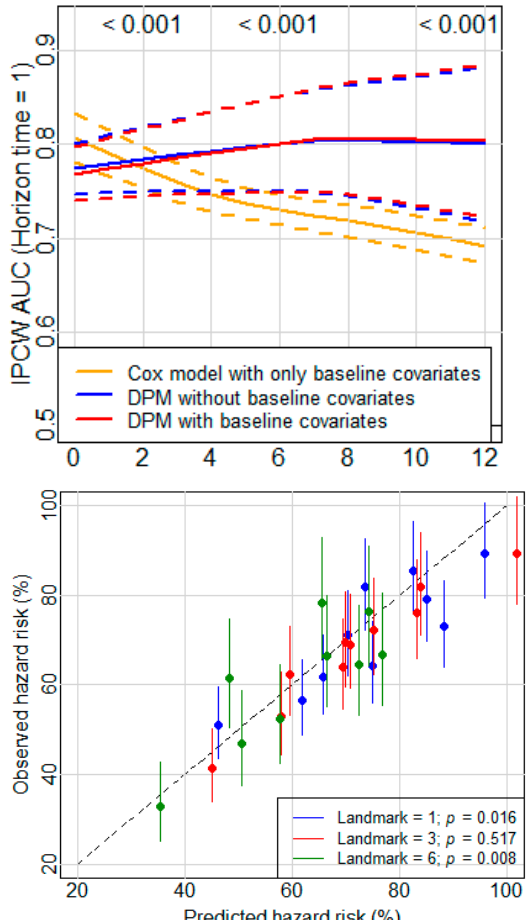
Figure 5. IPCW AUC and calibration plot for the DPM with time-dependent albumin and ECOG PS. p values at the top of the left plot are for comparing the DPM using both time-dependent variables and baseline covariates and the baseline Cox model at landmarks of 2, 6, and 12 months. p values in the right plot are from the Wald test wherein all the coefficients of a group are 0 or not.